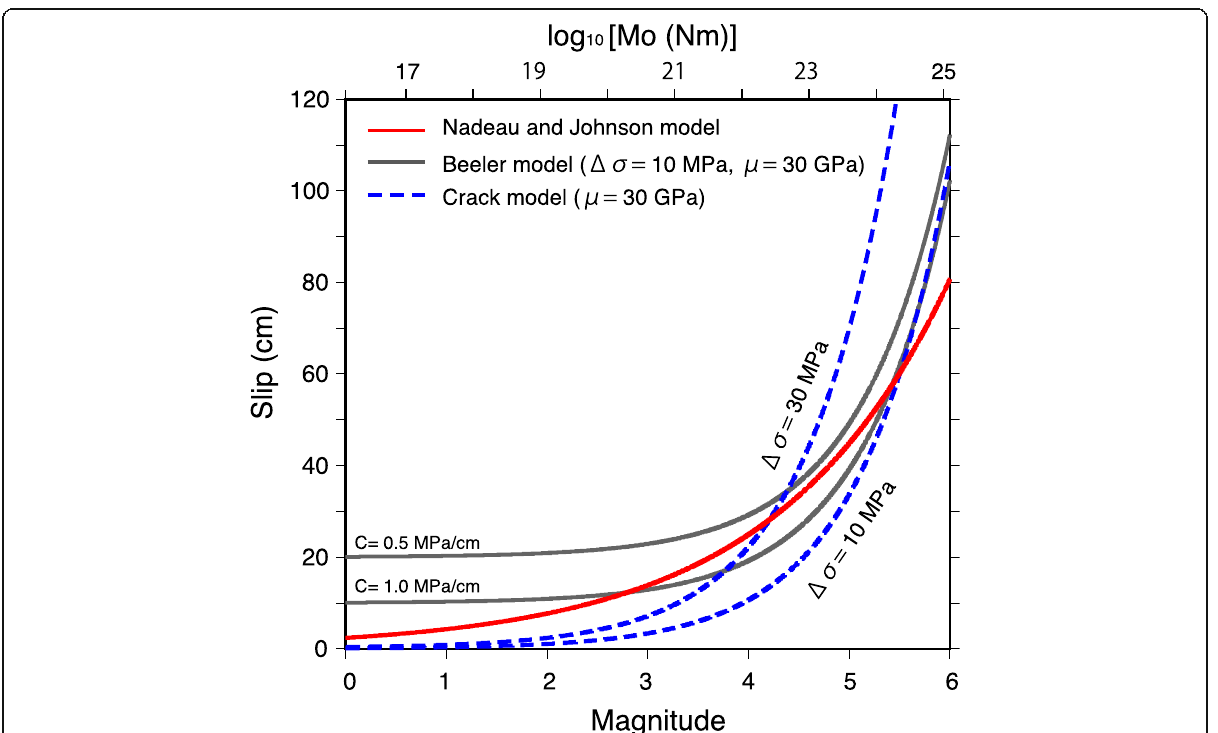
Fig. 9 Relationship between magnitude (moment) and slip for three models (Eqs. 4, 5, and 6). Note that the Beeler model has three additional parameters ( μ , Δ σ , C ), and the crack model has two additional parameters ( μ , Δ σ ). Rigidity is fixed to 30 GPa